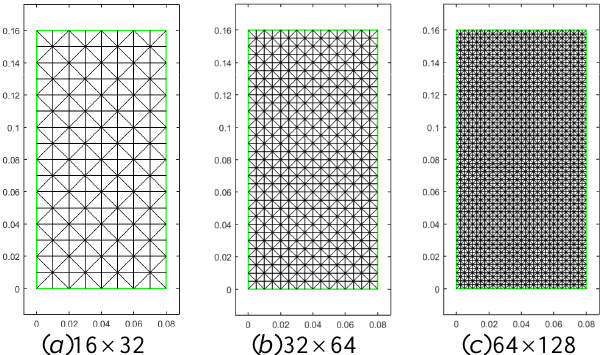
Figure 6. Initial meshes used for the simulations: ( a ) Coarse, ( b ) Medium, and ( c ) Fine.